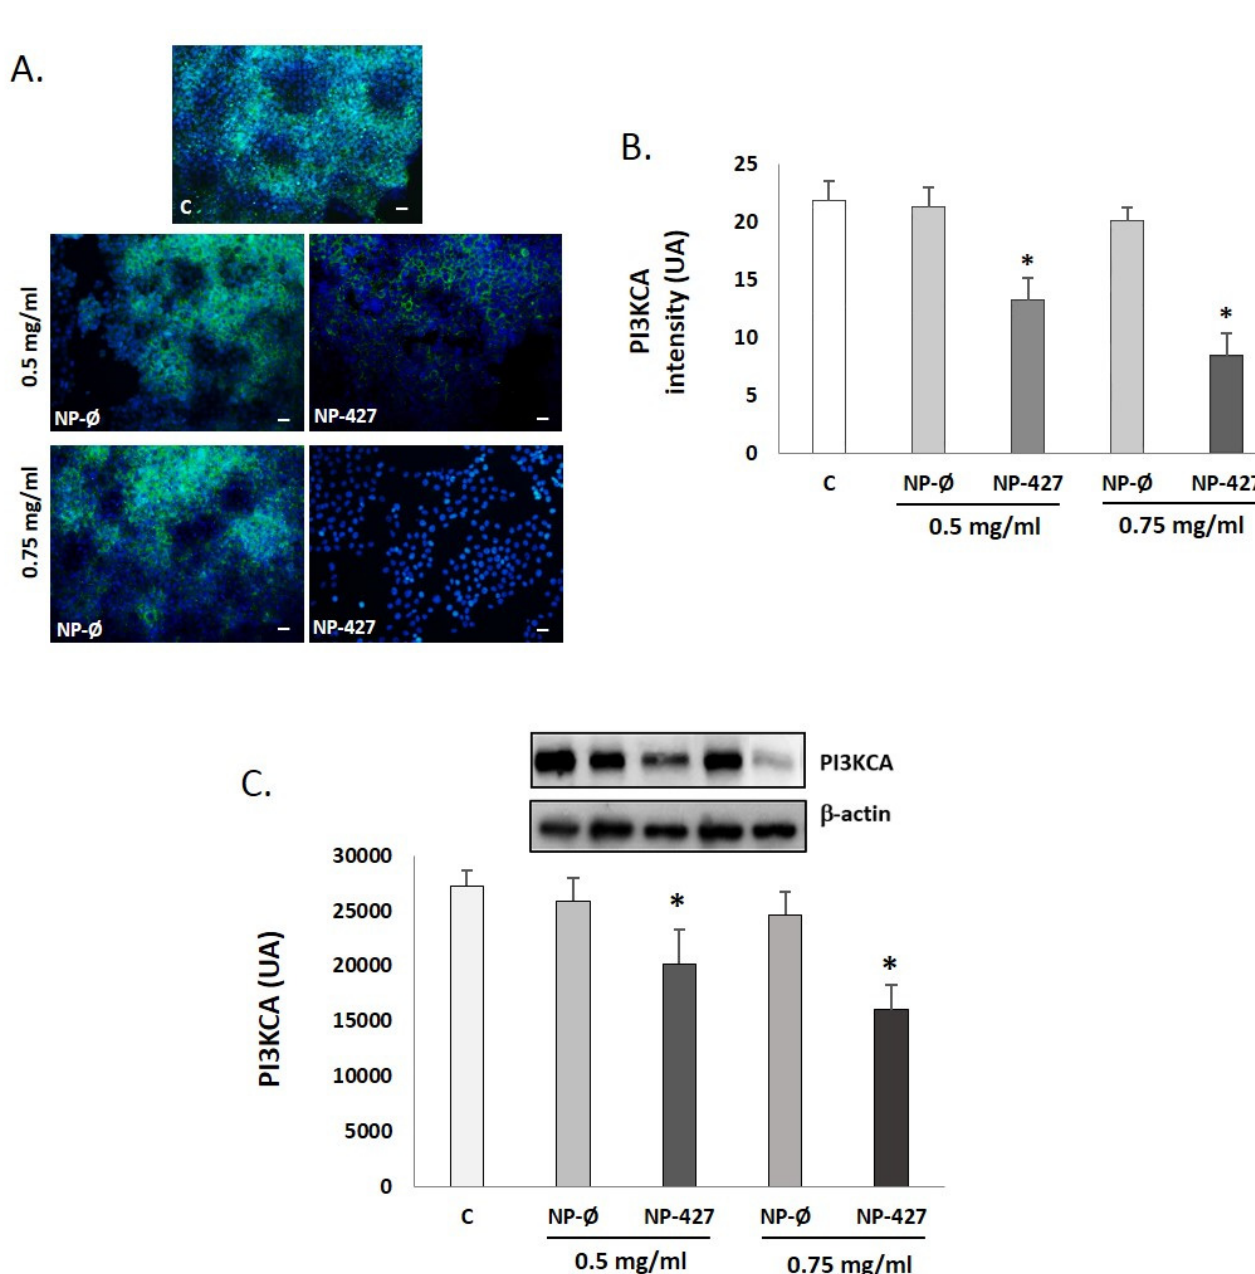
Figure 6. PI3KCA levels decrease with the treatment of nanoparticles loaded with PHT-427 on FaDu cells. ( A ) Representative Figure 3. KCA (green fluorescence) in FaDu cultures treated with C (control), NP-Ø (unloaded NPs, 0.5 and 0.75 mg/mL), and NP-427 (PHT427-loaded NPs, 0.5 and 0.75 mg/mL) for 24 h. DAPI labels nuclei with blue fluorescence. Scale bar: 100 µ m. The images were taken at random in a blinded fashion. ( B ) The bar graphs show the immunofluorescence intensity changes for PI3KCA by Image J. The values represent the mean ± SD arbitrary units (AU) in triplicate. * p < 0.05 versus the control and NP-Ø groups ( n = 4). ( C ) A representative Western blot and densitometry analysis for PI3KCA protein for each experimental group are shown. Loading control: β -actin. The bar diagrams represent the mean ± SD of arbitrary units (AU). * p < 0.05 vs. C and NP-Ø groups ( n = 4). PDK1 identification in immunofluorescence has a similar pattern to that of PI3KCA (Figure 7A). In FaDu cultures, green fluorescence decreased in the group with NP-427, in a dose-dependent manner, compared with the control and unloaded NP groups.